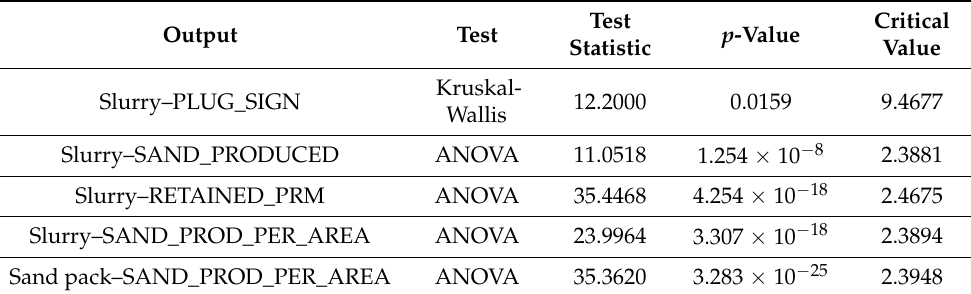
Table 17. Significance analysis using ANOVA and Kruskal–Wallis tests. Output